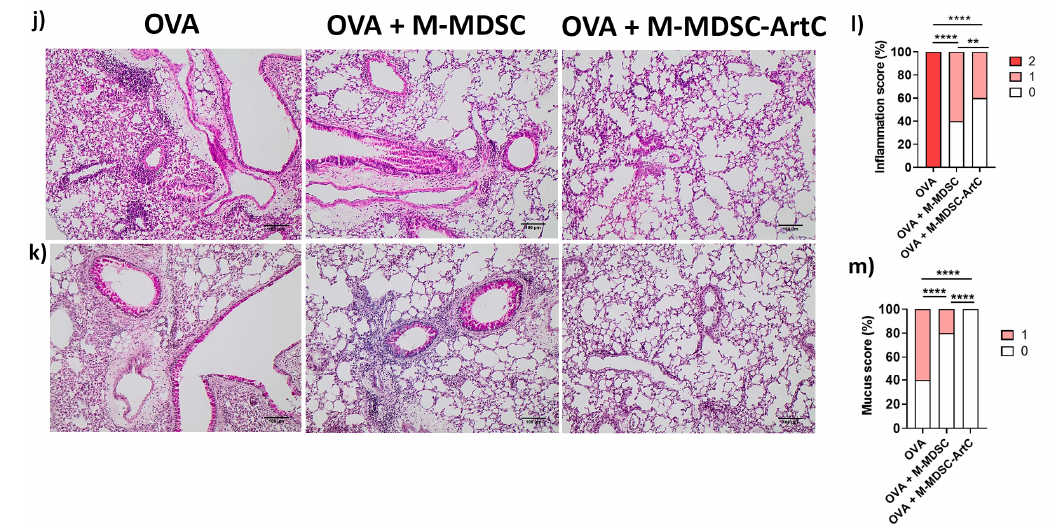
Figure 6. ArtC-induced M-MDSC reduces the allergic airway inflammation in mice. ( a ) Experimental design; ( b ) sorted M-MDSC, before cell transfer; ( c ) frequency and ( d ) number of eosinophils (EOS), lymphocytes (LYM), mononuclear cells (MON) and polymorphonuclear cells (PMN) in the BALF post cell transfer; ( e ) IL-4 and ( f ) IL-5 levels in the lungs; ( g ) representative dot plot of M- and PMN-MDSC in the lungs of post cell transfer; ( h ) percentage and ( i ) number of M-MDSC in the lungs; ( j ) representative images of lung inflammation (magnification 200 × , scale bar 100 µ M) and ( k ) mucus production (magnification 200 × , scale bar 100 µ M); ( l ) Lung inflammation score (0—without inflammation; 1—mild; 2—moderate to severe inflammation); ( m ) Mucus score (0—without mucus secretion; 1—mild). Data are representative of two independent experiments (n = 5–6/group/experiment), except for ( e – h ) (one representative experiment), and expressed by mean ± SD. * p < 0.05, ** p < 0.01, *** p < 0.001 and **** p < 0.0001.